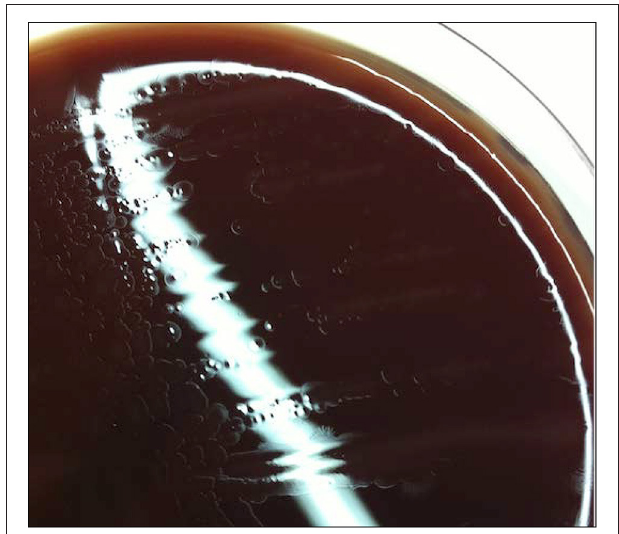
FIGURE 1 | Aspect of S15 colonies on trypcase soy agar. Culture of an identified organism on trypcase soy agar enriched with 5% horse blood for 2–3 days at 37 ◦